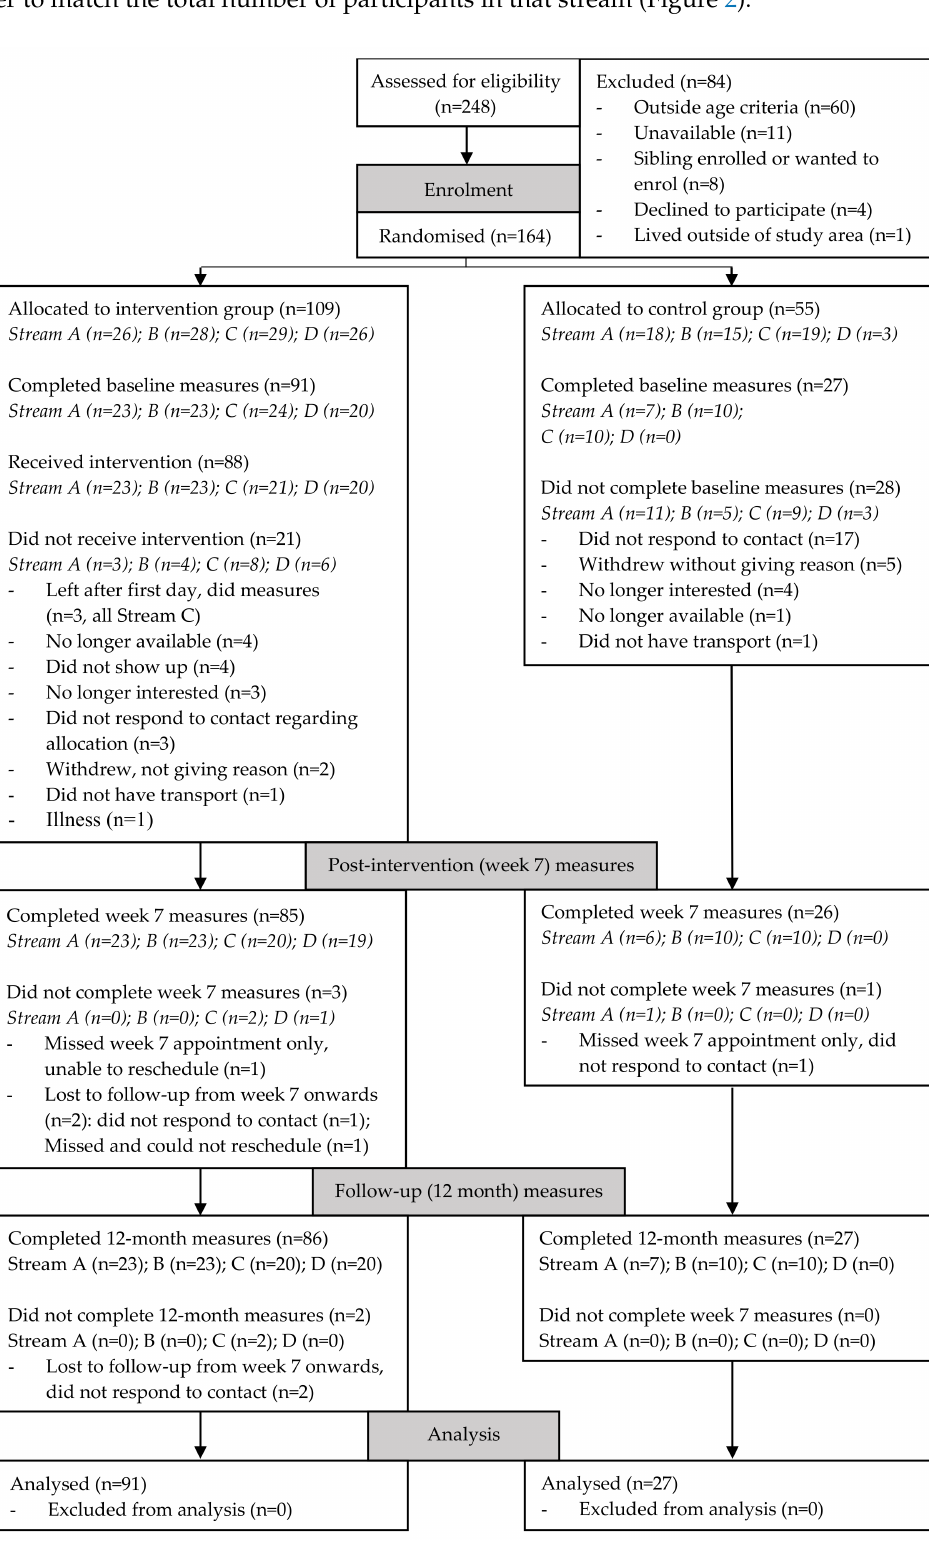
Figure 2. Participant flow during the COOK